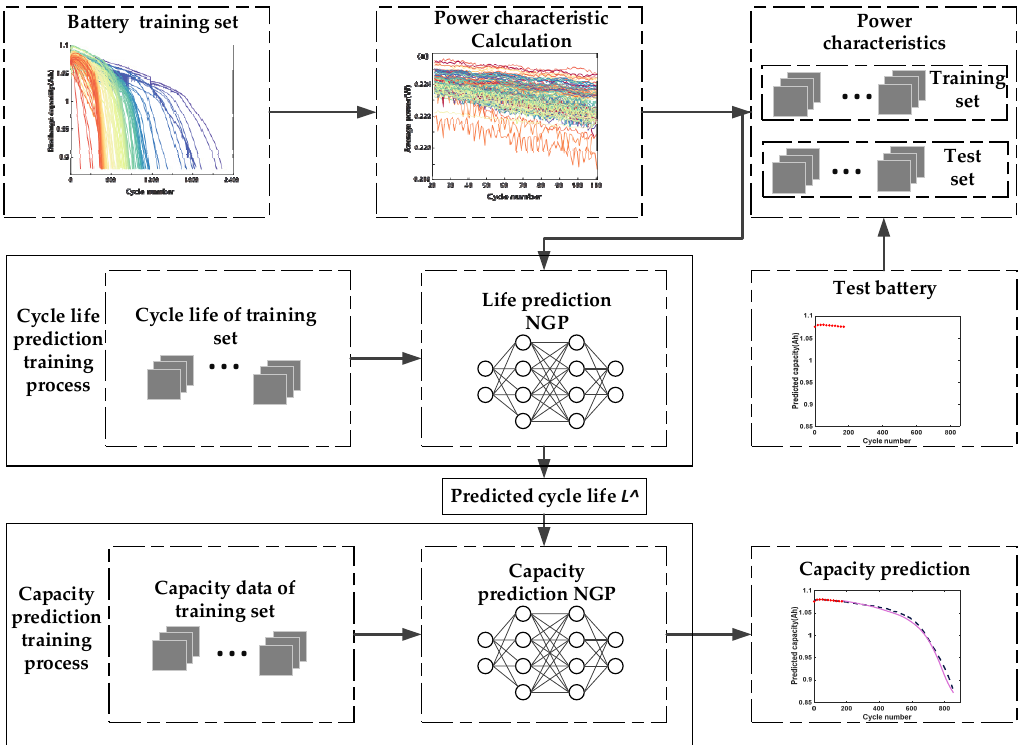
Figure 4. The flow chart of battery cycle life and capacity prediction.